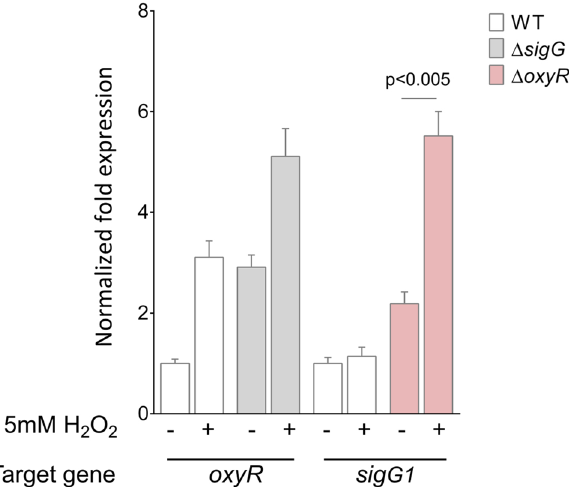
Figure 6. Stress-responsive gene expression. Transcription analyses of oxyR and sigG1 expression in S. tsukubaensis mutant strains, upon a H 2 O 2 stimulus evaluated by RT-qPCR. The Mean Normalised Fold Expression of the target genes was calculated relatively to the transcription of the reference genes ( rpsP and hrdB ) and internal normalisation was performed using the wild-type as the control. Results are